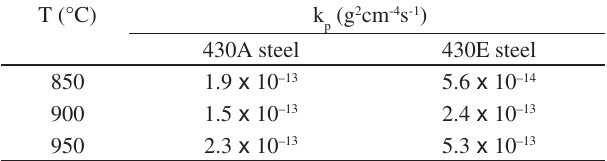
Table 2. Parabolic oxidation